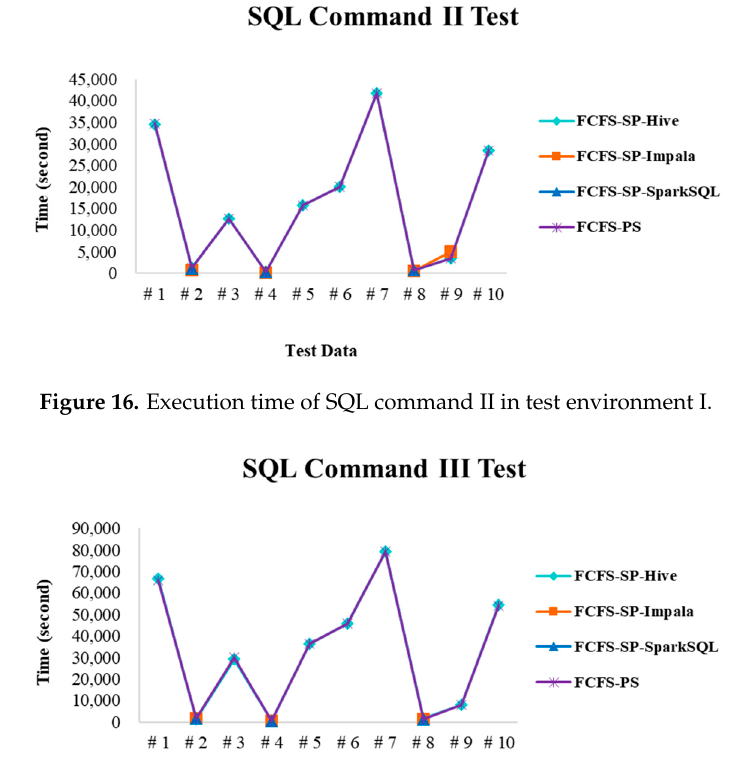
Figure 17. Execution time of SQL command III in test environment I.